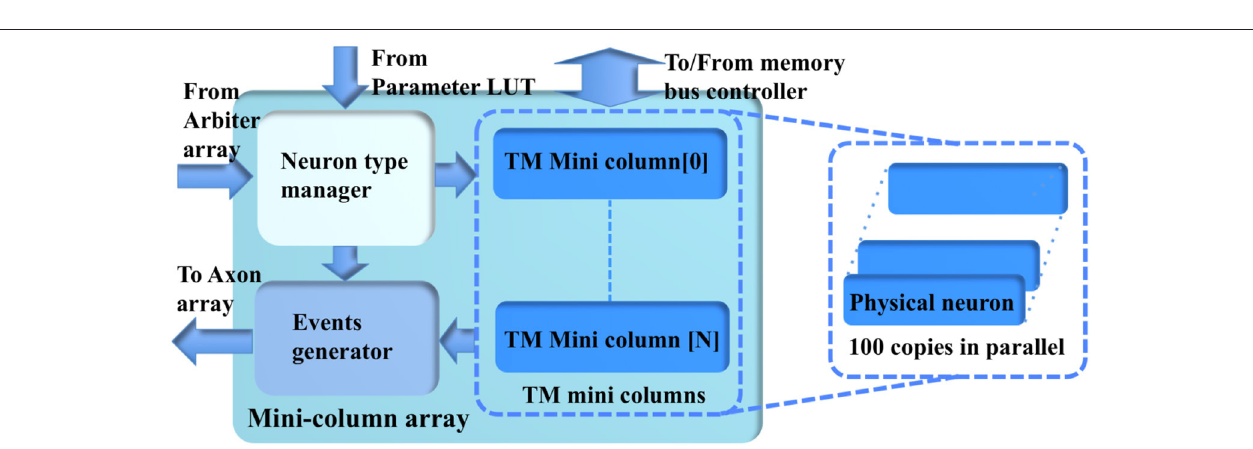
FIGURE 7 | The structure of the minicolumn